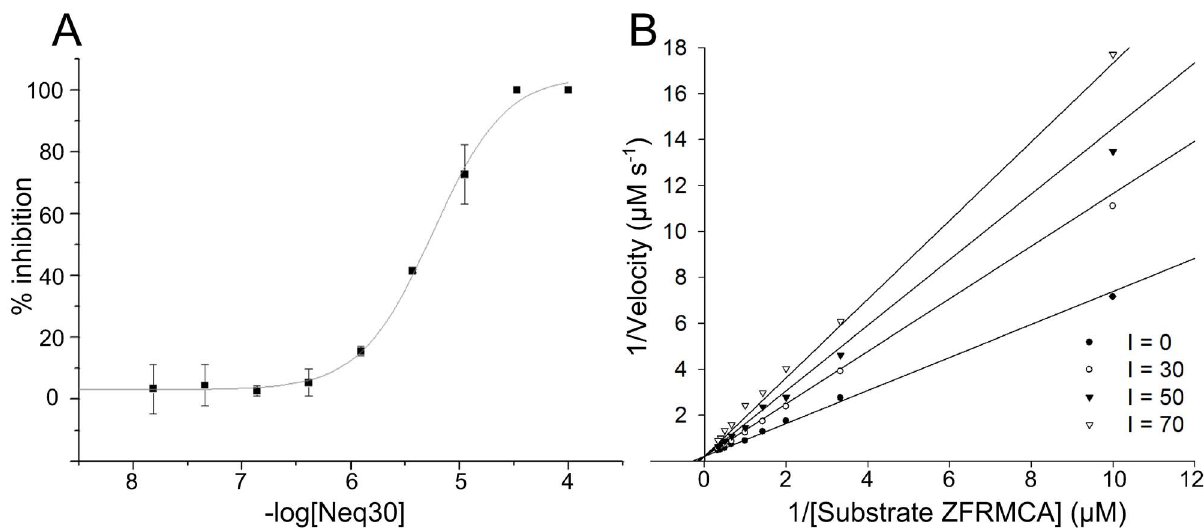
Figure 4. (A) Dose-response and (B) Linewaver-Burk curves for Neq30 from Table S1. Non-linear fit method was employed in the analysis.